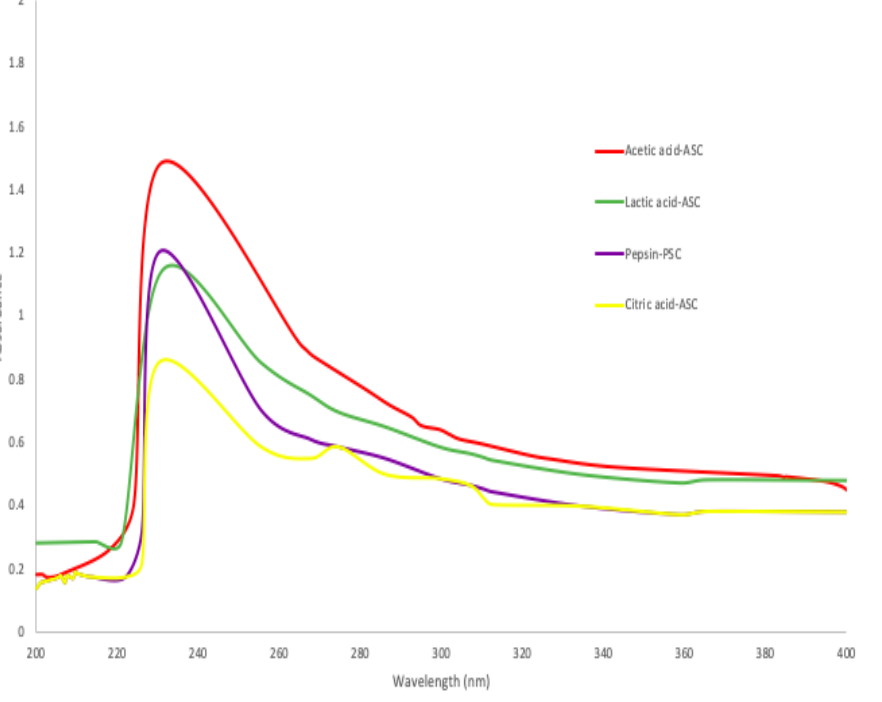
Figure 1. Ultraviolet spectra of collagen extracted ASC and PSC from skin of purple-spotted bigeye.